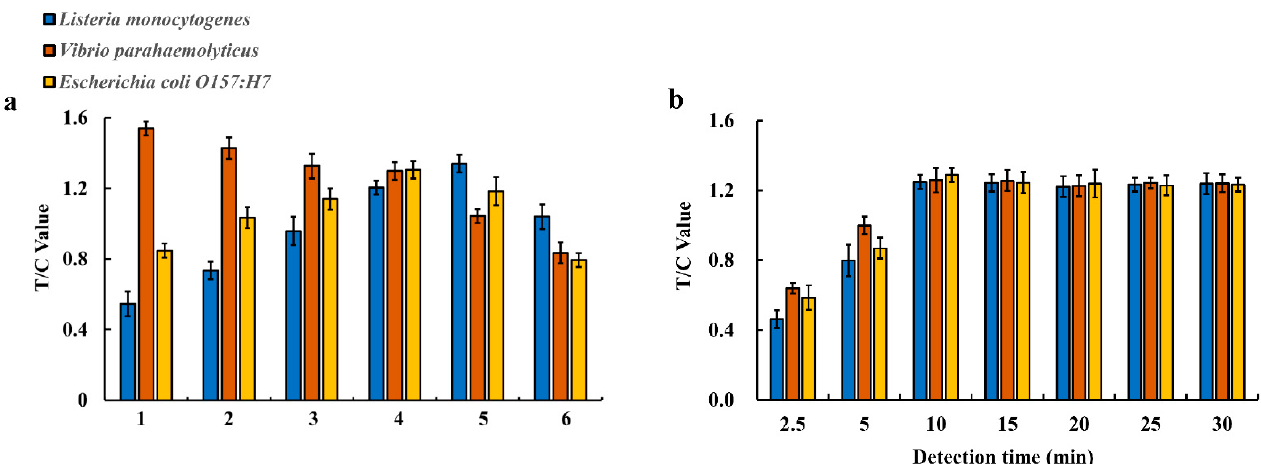
Figure 2. Optimization of the EuNP-based LFIA–RPA reaction. ( a ) Different primer concentrations of Listeria monocytogenes , Vibrio parahaemolyticus , and Escherichia coli O157:H7 . 1: 150 nM (blue), 150 nM (orange), 150 nM (yellow); 2: 200 nM (blue), 150 nM (orange), 200 nM (yellow); 3: 250 nM (blue), 150 nM (orange), 250 nM (yellow); 4: 300 nM (blue), 150 nM (orange), 300 nM (yellow); 5: 350 nM (blue), 150 nM (orange), 350 nM (yellow); 6: 400 nM (blue), 150 nM (orange), 400 nM (yellow). Blue represents Listeria monocytogenes , orange represents Vibrio parahaemolyticus , and yellow represents Escherichia coli O157:H7 . ( b ) Different detection times: 2.5 min, 5 min, 10 min, 15 min, 20 min, 25 min, and 30 min. The Y-axis represents the test line intensity (T/C value).